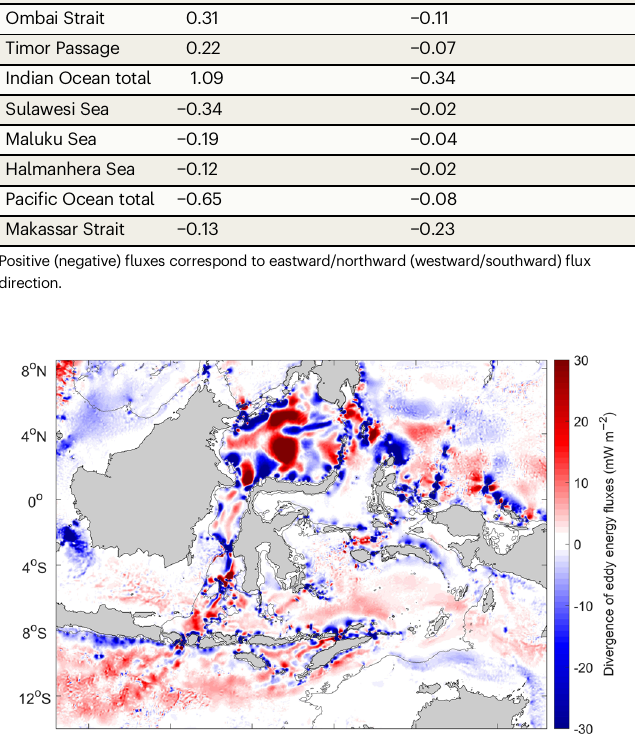
Fig. 2 | Eddy energy fl uxes. Time-averaged, vertically-integrated ( a ) radiative and ( b ) advective eddy energy fl uxes in (kWm − 1 ; 1kWm − 1 =10 3 Wm − 1 ). The magnitude of the energy fl uxes is shown in color on a logarithmic scale. Energy fl ux vectors represent 0.4°×0.4° bin-averaged values. 200m isobath isshown by the thin gray